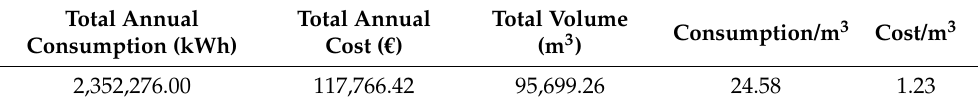
Table 4. Global Infrastructure parameters.